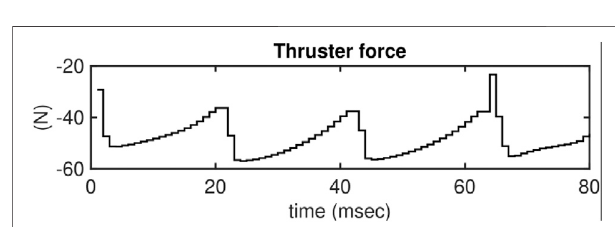
FIGURE14| IllustratesthefrictionconstraintsduringtheDSphaseofleg 1and2.Inthisplot,theintermediateSSphasesareomitted.Dashedbluelines are the